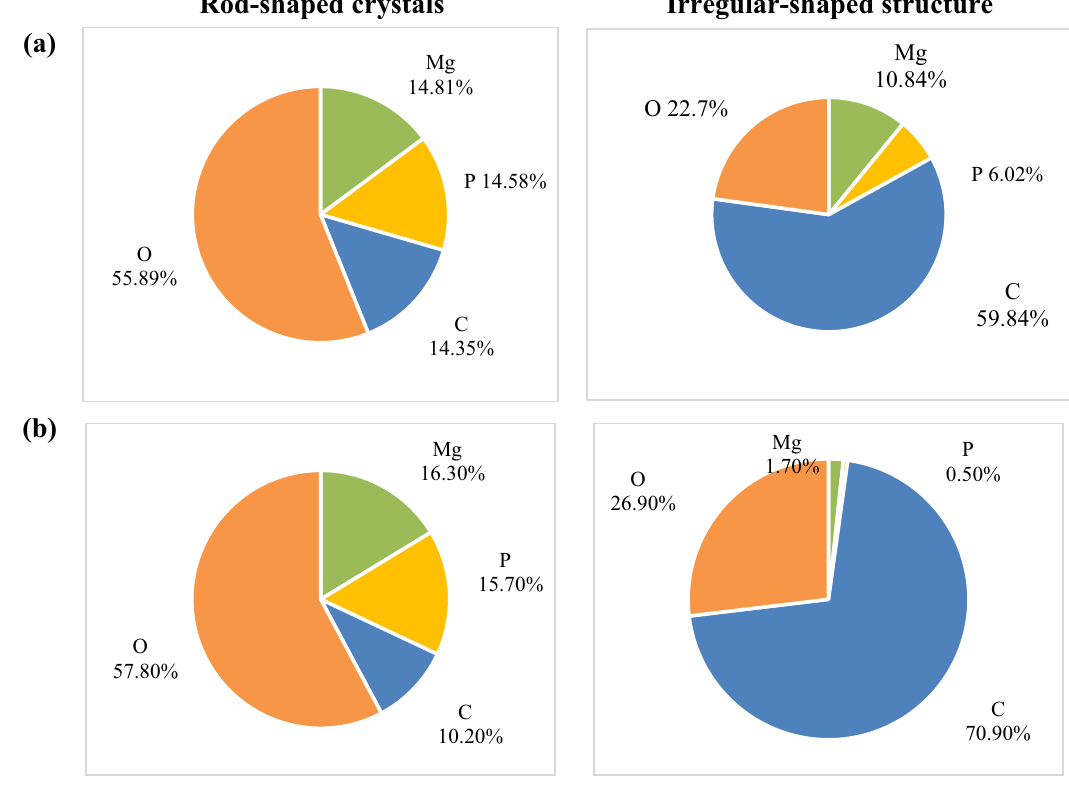
Figure 6. EDS analysis (atom%) of rod-shaped crystal and irregular structure observed in SEM images of the precipitates based on point analysis from the synthetic supernatant (pH = 7.9, alkalinity = 3000 mg/L as CaCO 3 ) with lignin of ( a ) 0 g/L and ( b ) 6 g/L.